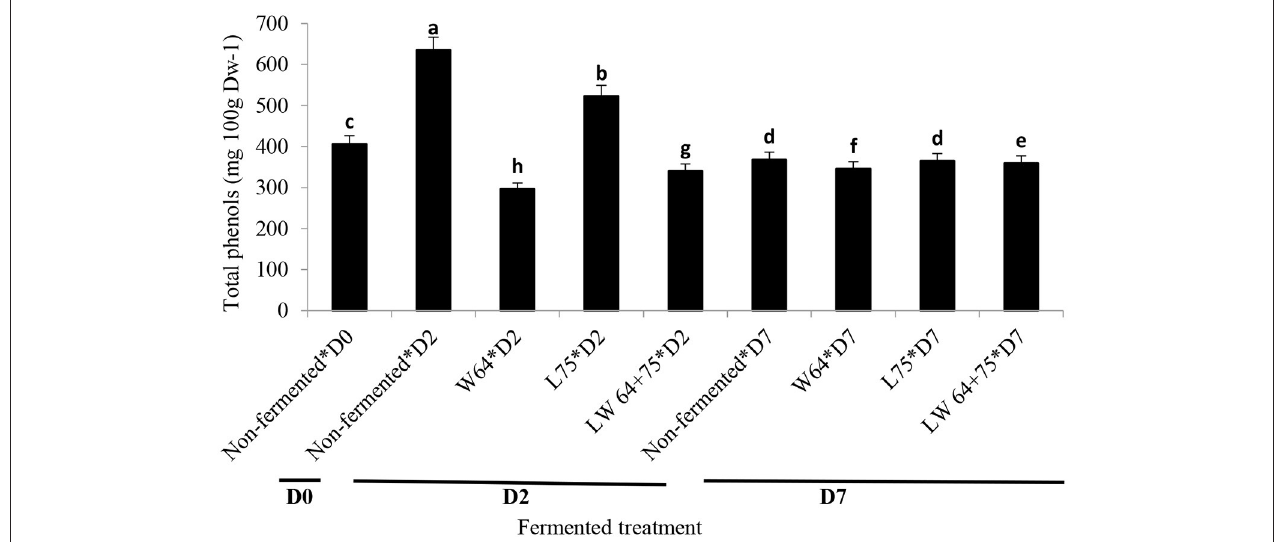
FIGURE 5 | Changes in total polyphenol content (TPC) during fermentation of smoothies. Bars with different alphabetic letters are significantly different at p < 0.0001 level. W64, Weissella cibaria 64; L75, Lactobacillus plantarum 75 ; LW64 + 75, W. cibaria 64 + L. plantarum 75; D0, day 0; D2, 2 days; D7, 7 days; DW, dry weight; non-fermented smoothies